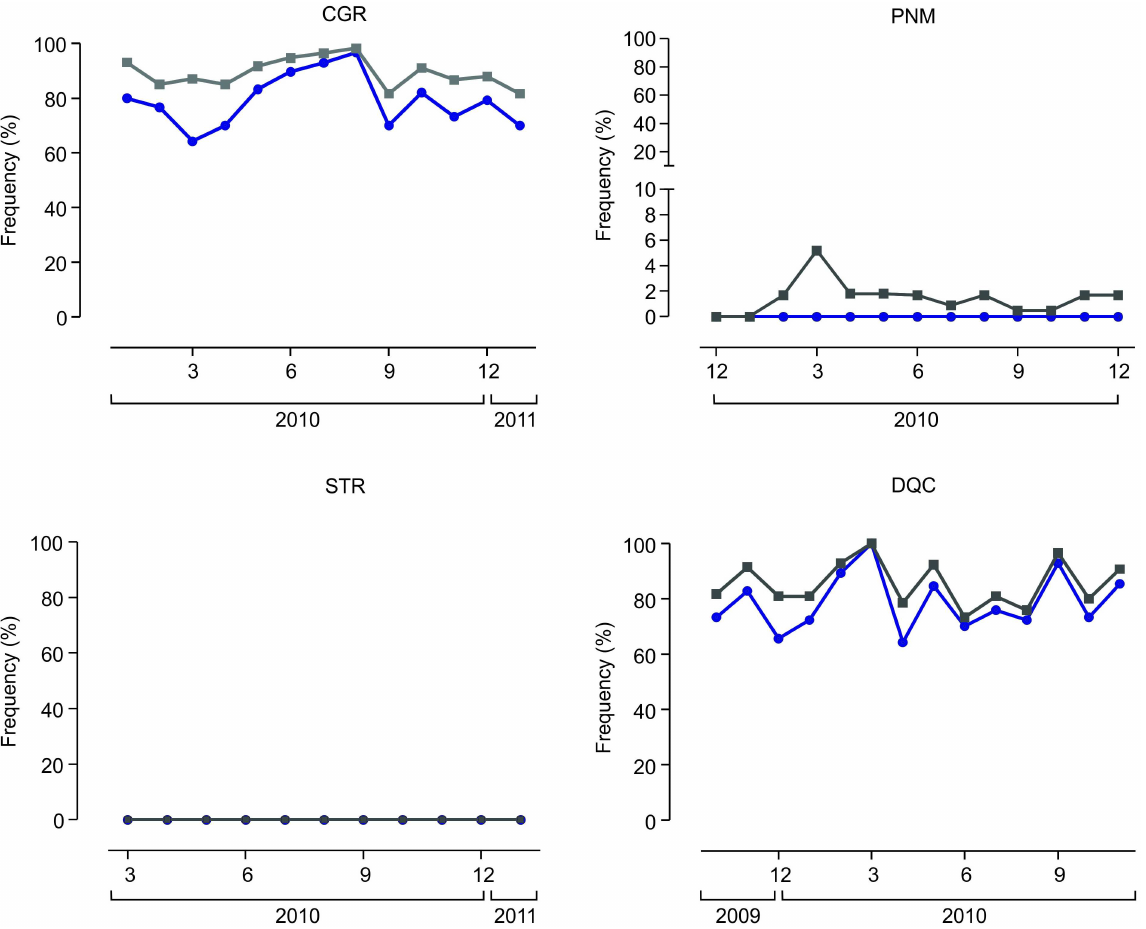
Fig 5. Allelic (grey) and genotypic (blue) frequencies of the Ae . aegyptikdr Val1016Ile substitution in the Na V . Populations names were abbreviated as in Fig 4. Note that the y-axis scale of the Parnamirim (PNM) population was altered in order to enable a better visualization of frequency variations.